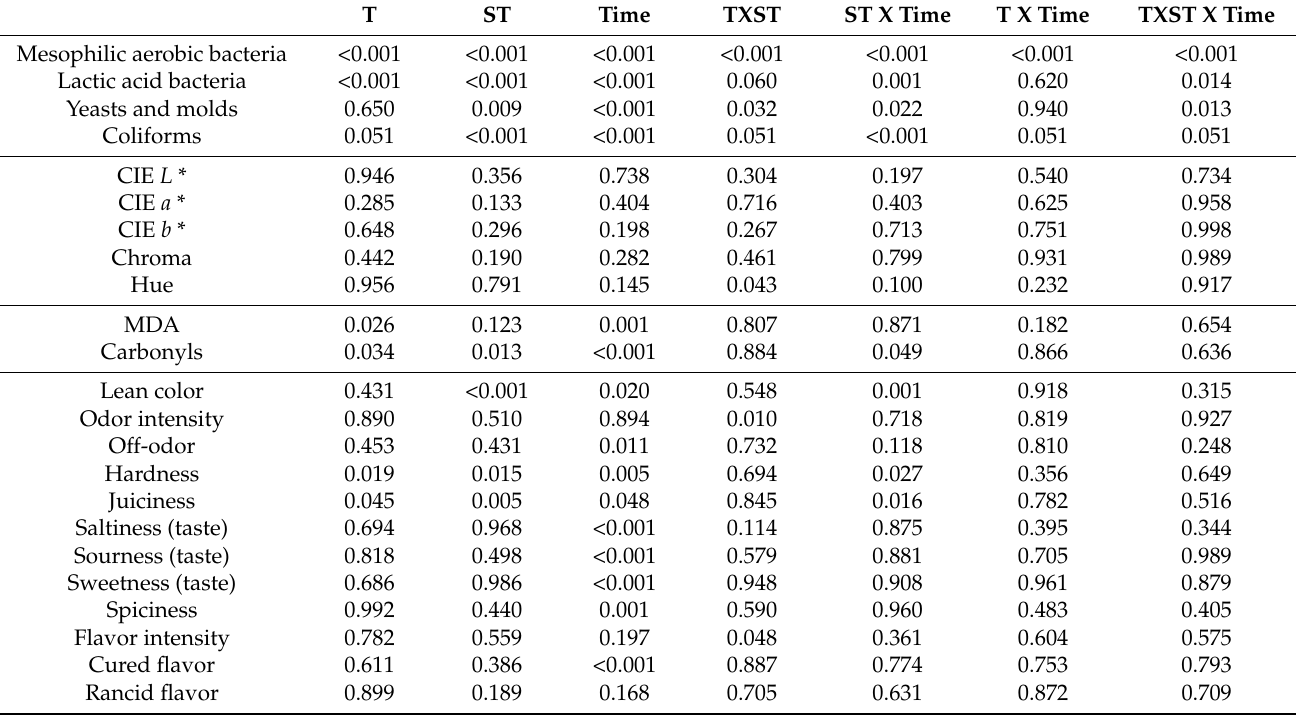
Table 5. Significance from a three-way (HPP: T; storage temperature: ST; and storage time) ANOVA with interaction performed on the data from the samples stored for 90 and 180